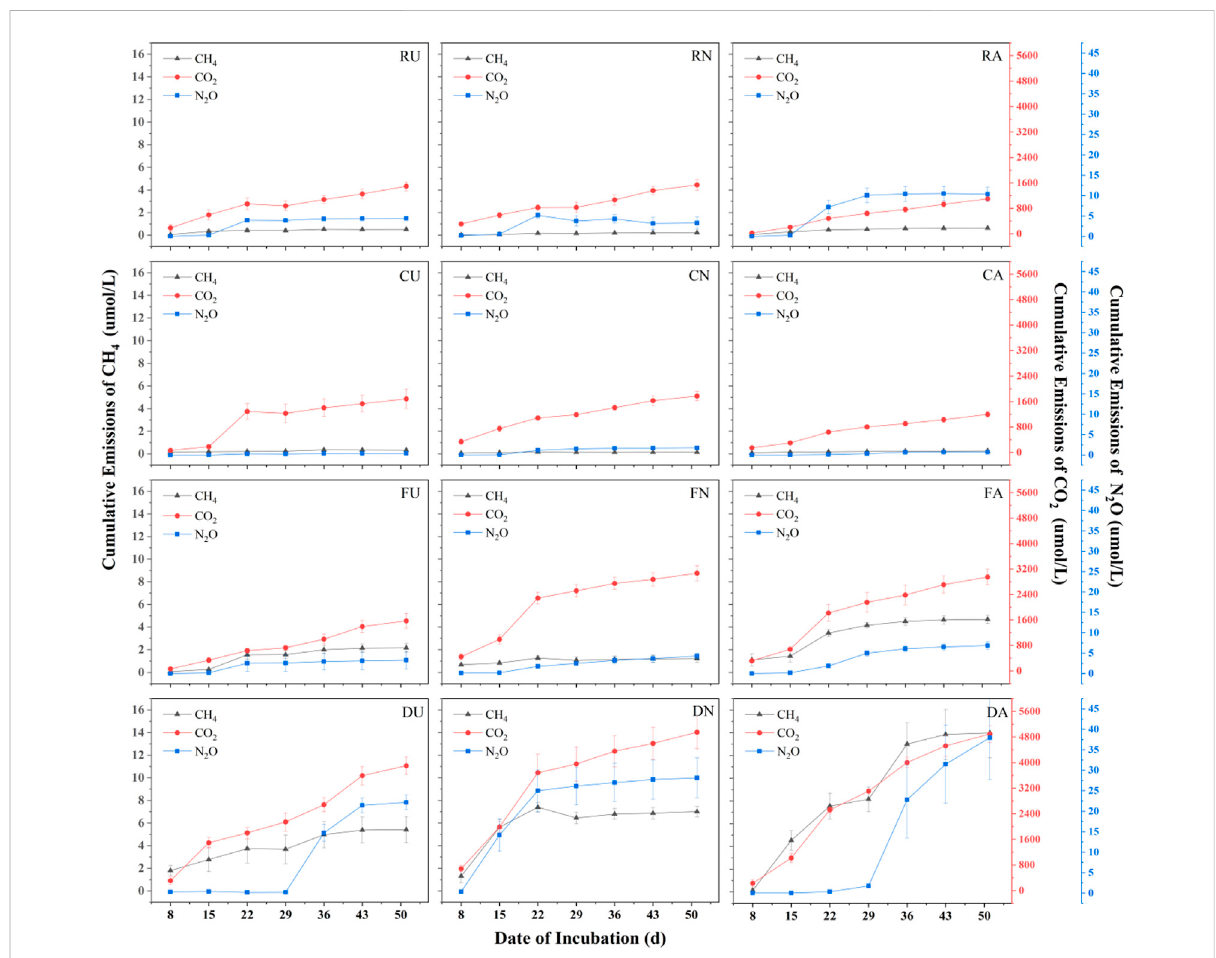
FIGURE 2 Changes in cumulative CH 4 , CO 2 and N 2 O emissions over 50 days for different treatments, where R, C, F, & D represent Chu River riparian sediment, Hongshan Gate sediment, Fish pond interchange sediment, D Zero-interchange fi sh pond sediment respectively. Moreover, U, N, and